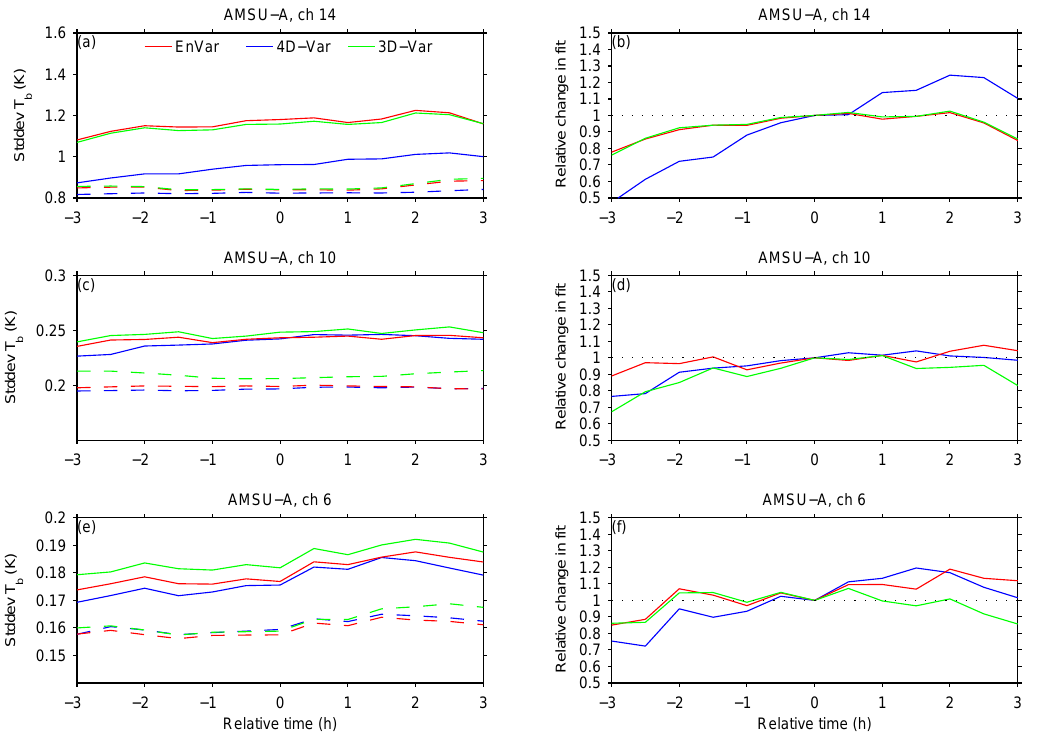
Fig. 13. Same as the previous figure, except for brightness temperature observations from AMSU-A channel 14 (upper panels), 10 (middle panels), and 6 (lower